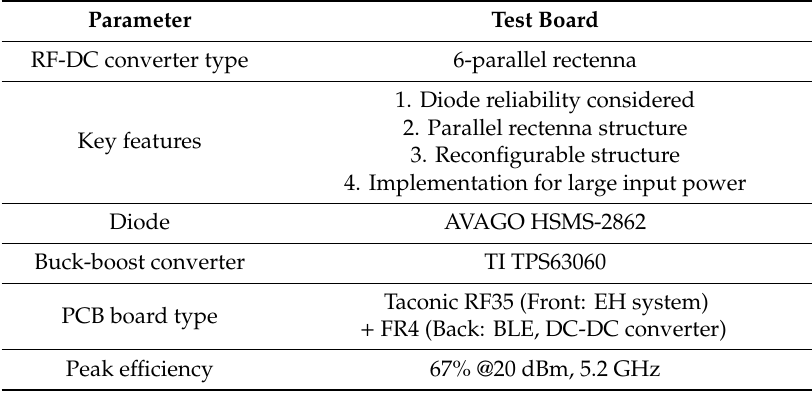
Table 2. Performance Summary. Reprint with permission [4775431338148]; 2020, IEEE.